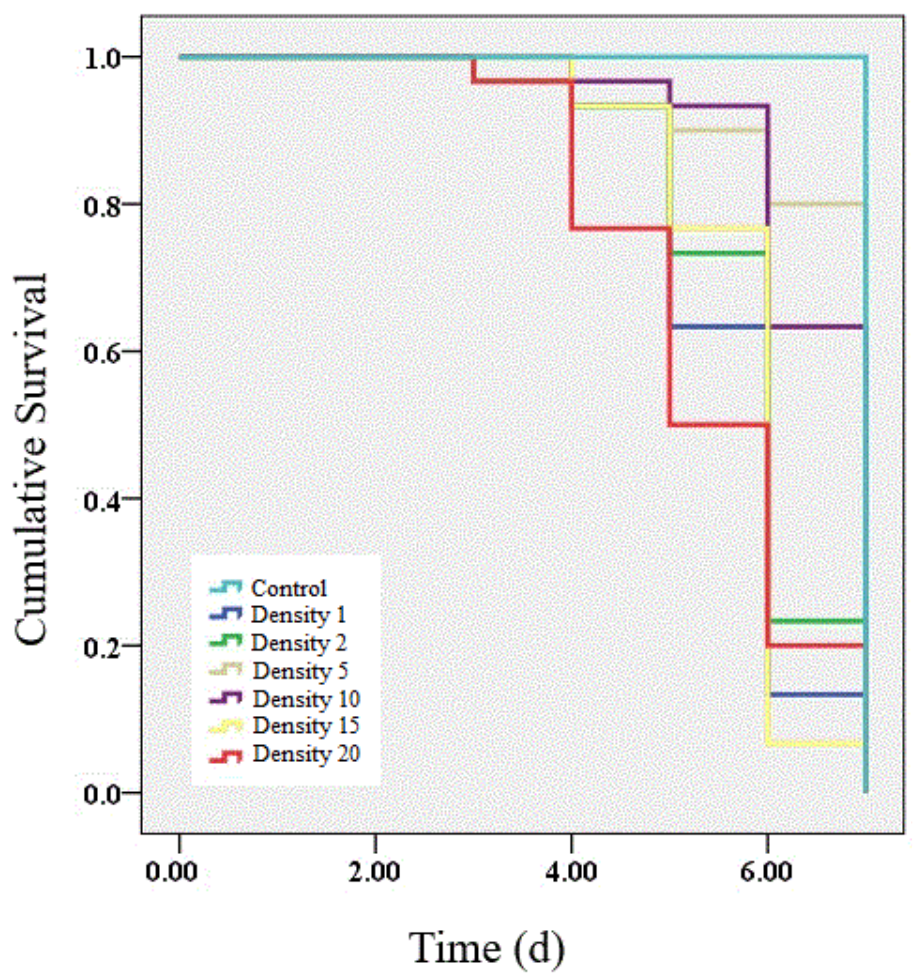
Figure 1. Survival analysis of larvae infected with granulosis virus at di ff erent larval densities. The average survival rates of larvae infected for 7 d at densities of 1, 2, 5, 10, 15, and 20 larvae per Petri dish were 63.33%, 66.67%, 70.00%, 66.67%, 73.33% and 76.67%, respectively. A log-rank test was used to determine which curves were significantly di ff erent from each other. Survival analysis was performed using the Kaplan–Meier estimator in SPSS